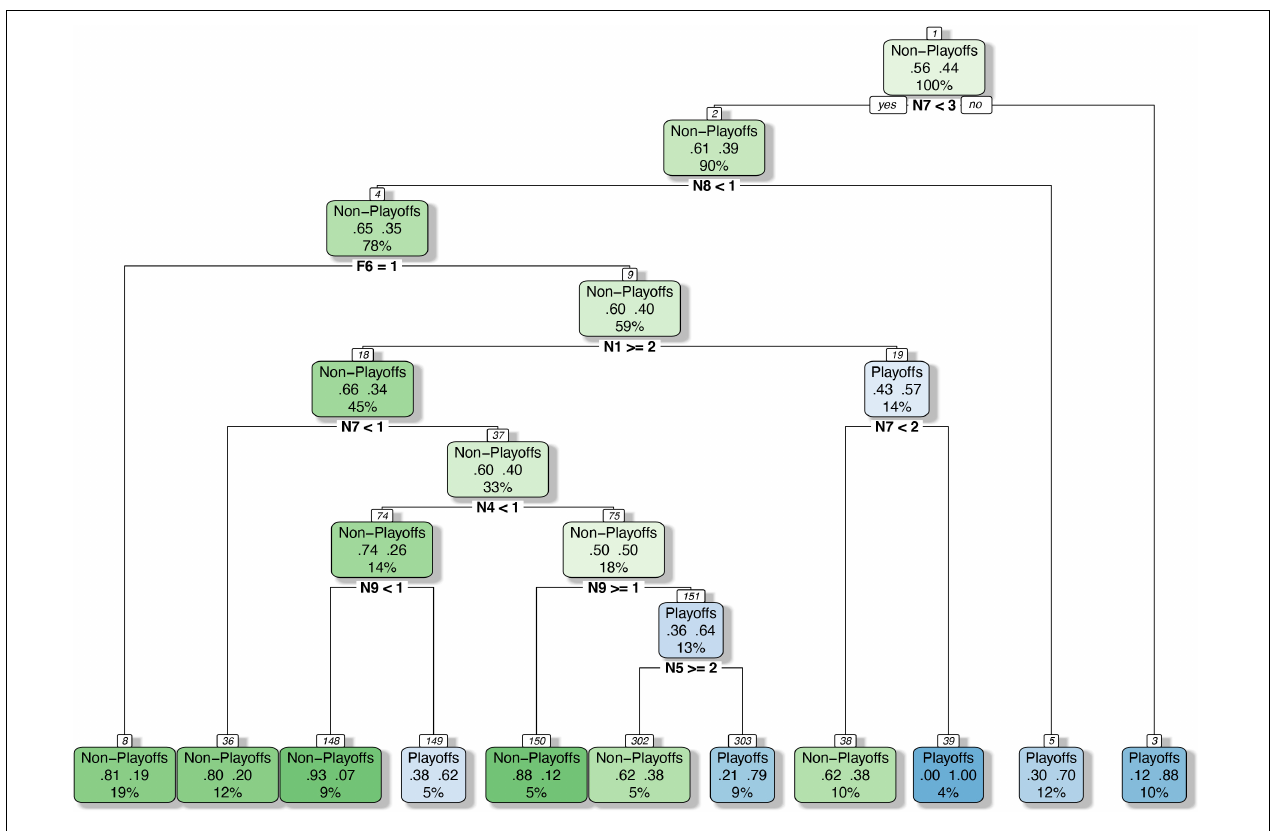
FIGURE 3 | Classification and regression tree analysis of team